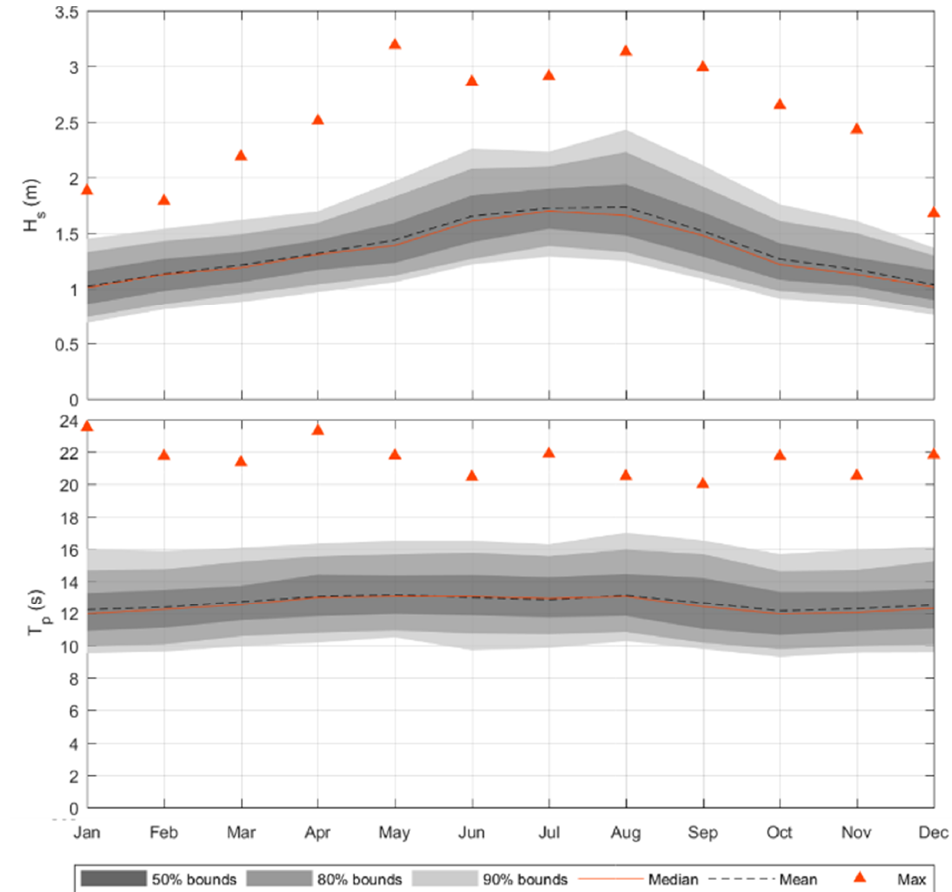
Figure 3. Seasonal characteristics’ significant wave height and peak period, based on offshore hindcast wave data from the NOAA WAVEWATCH III ® Hindcast and Reanalysis Archives for location 6° N, 4° E for the period February 2005–June 2019.